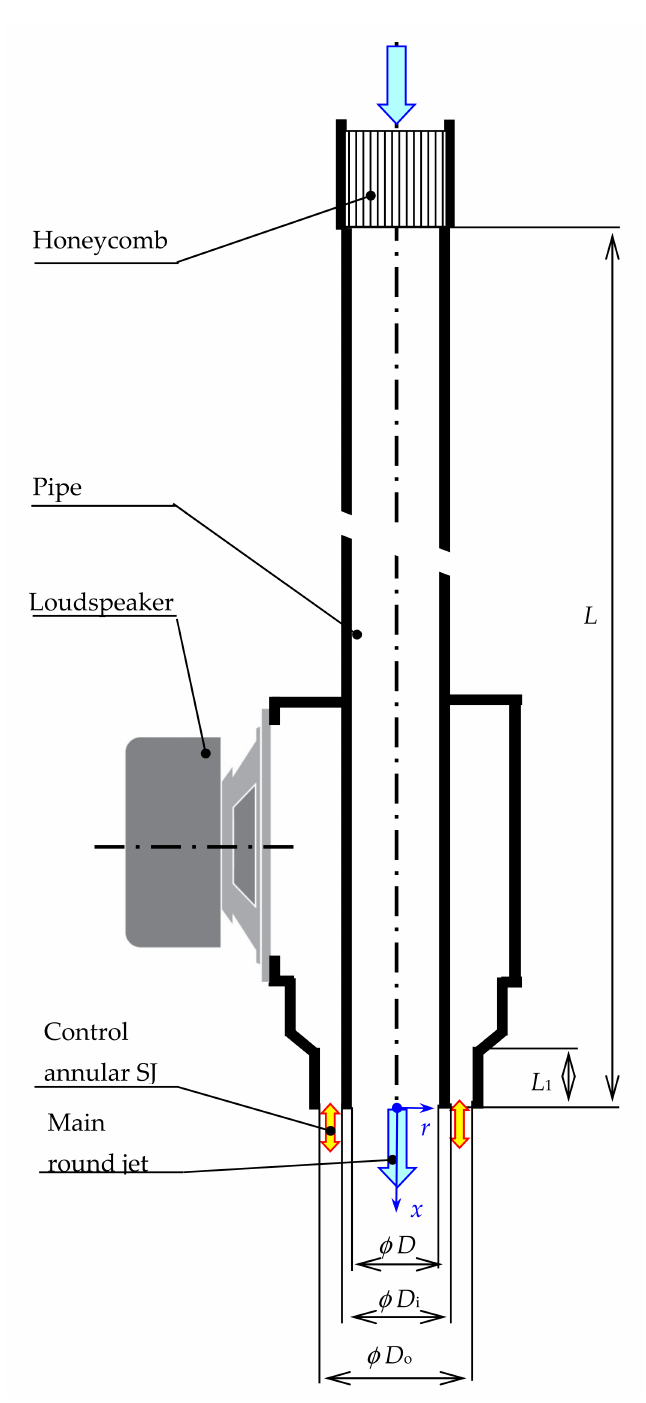
Figure 2. Investigated configuration (drawing not to scale); dimensions: ϕ D = 10.05 mm; D i = 11.95 mm; ϕ D i = 15.05 mm; L 1 = 12.5 mm; L = 750